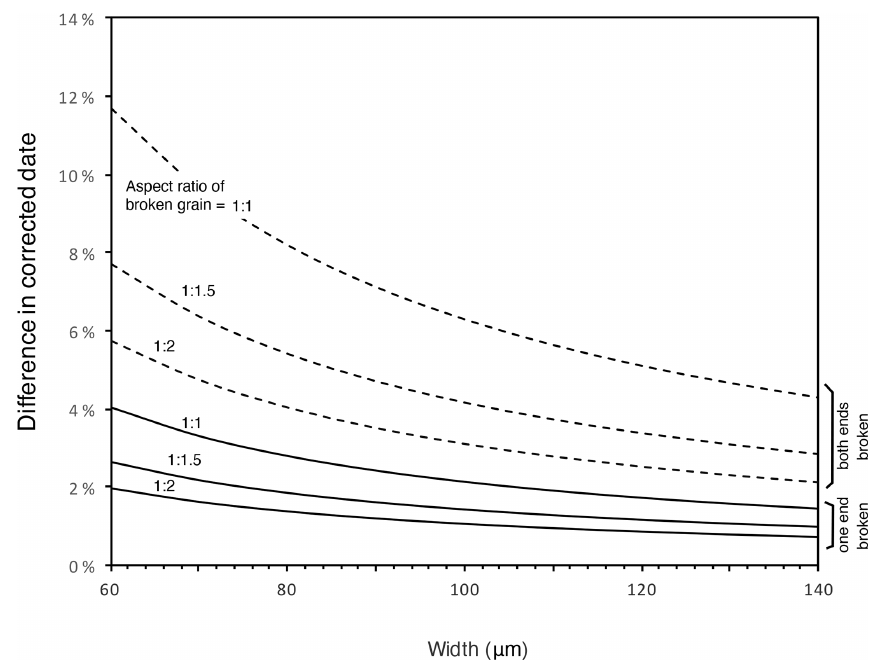
Figure 4. Difference between the corrected dates calculated from the standard protocol and revised protocol (dashed – broken on both ends; solid – broken on one end), shown for a range of width-to-length ratios commonly seen in broken crystals.